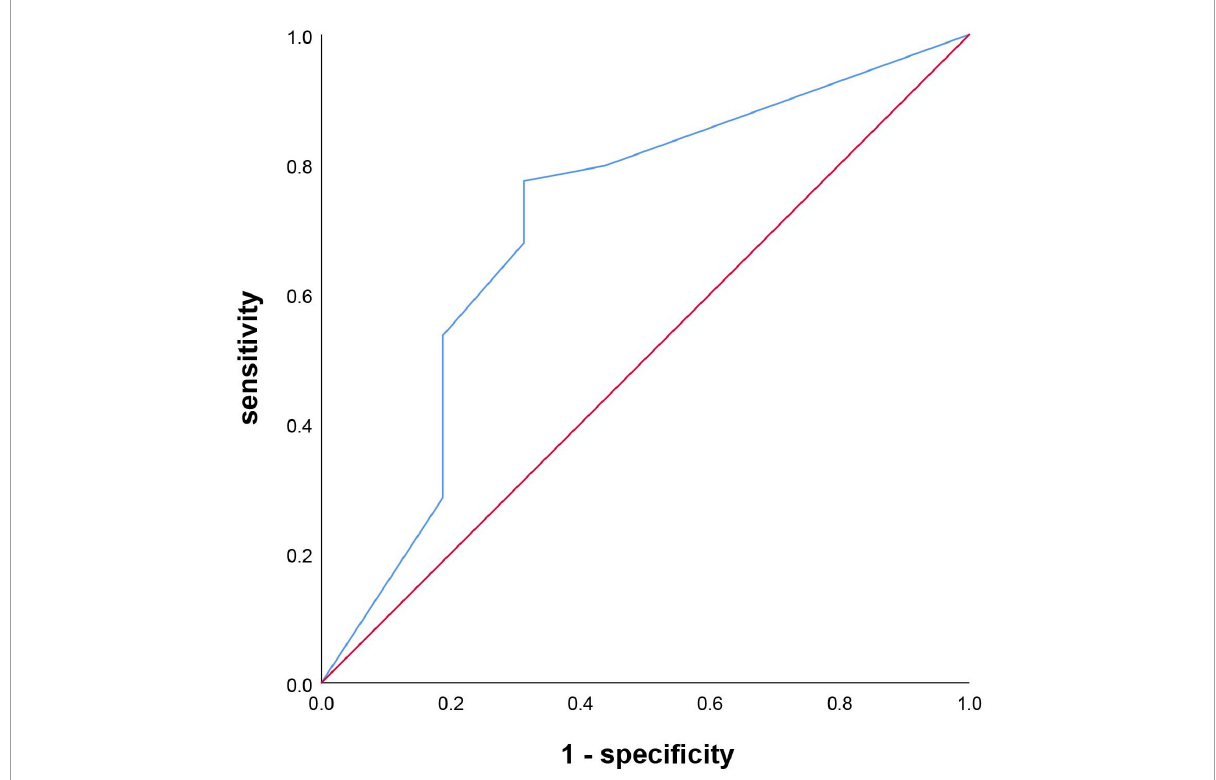
FIGURE5 Receiver operating characteristic curve on predicting 3-month functional